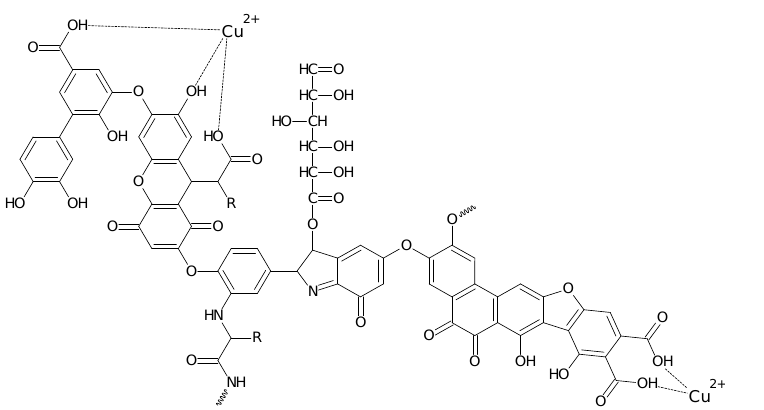
Figure 6. Organic humin-based chemical compounds are found in alginite: ( a ) the general chemical structure of fulvic acid; ( b ) humic acids.